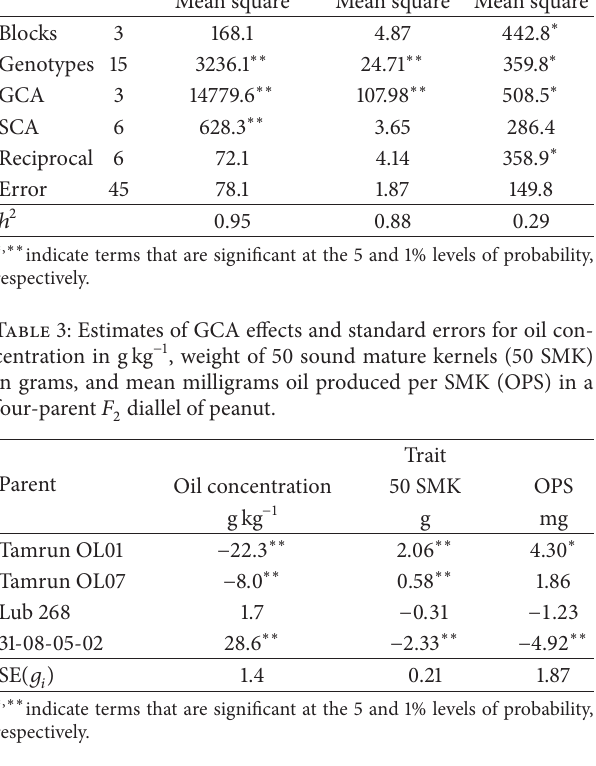
Table 2: Griffing’s analyses of variance and narrow-sense heri- tability estimates ( ℎ 2 ) for oil concentration in gkg − 1 , weight of 50 sound mature kernels (50 SMK) in grams, and mean milligrams oil produced per SMK (OPS) in a four-parent 𝐹 2 diallel of peanut.